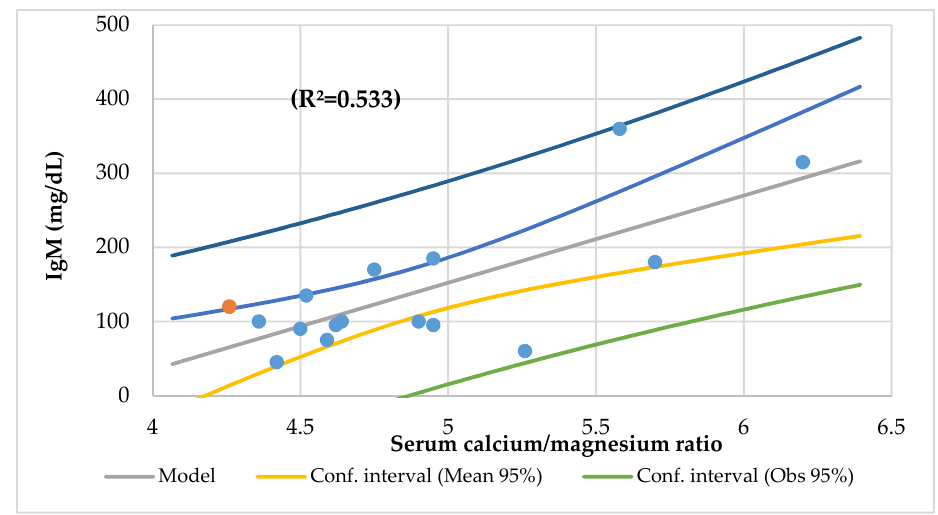
Figure 9. Regression IgM (mg/dL) by serum calcium/magnesium ratio.